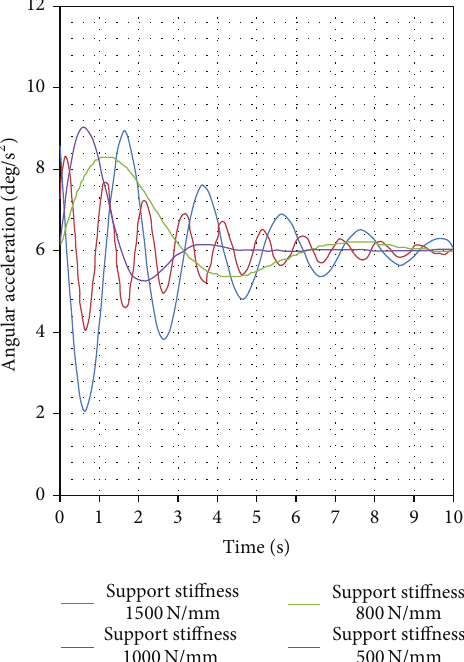
Figure 6: Angular acceleration plots for the driven gear for different stiffness